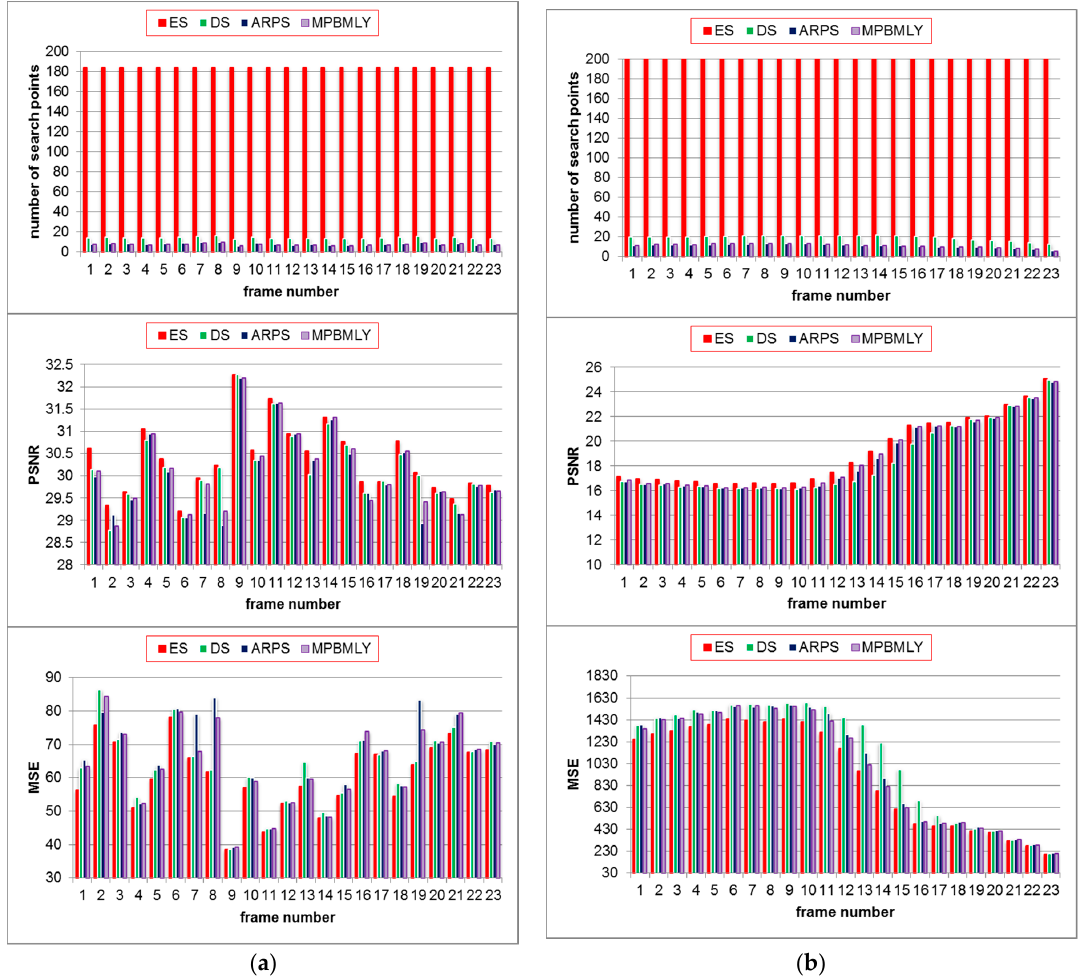
Figure 9. Average number of search points per MB (Top), PSNR performance (Middle), and MSE (Bottom) for MPBMLY and state-of-the-art fast block matching. (a) Average for the “Carphone” video sequence over 23 frames; (b) average for Stefan” video sequence over 23 frames.